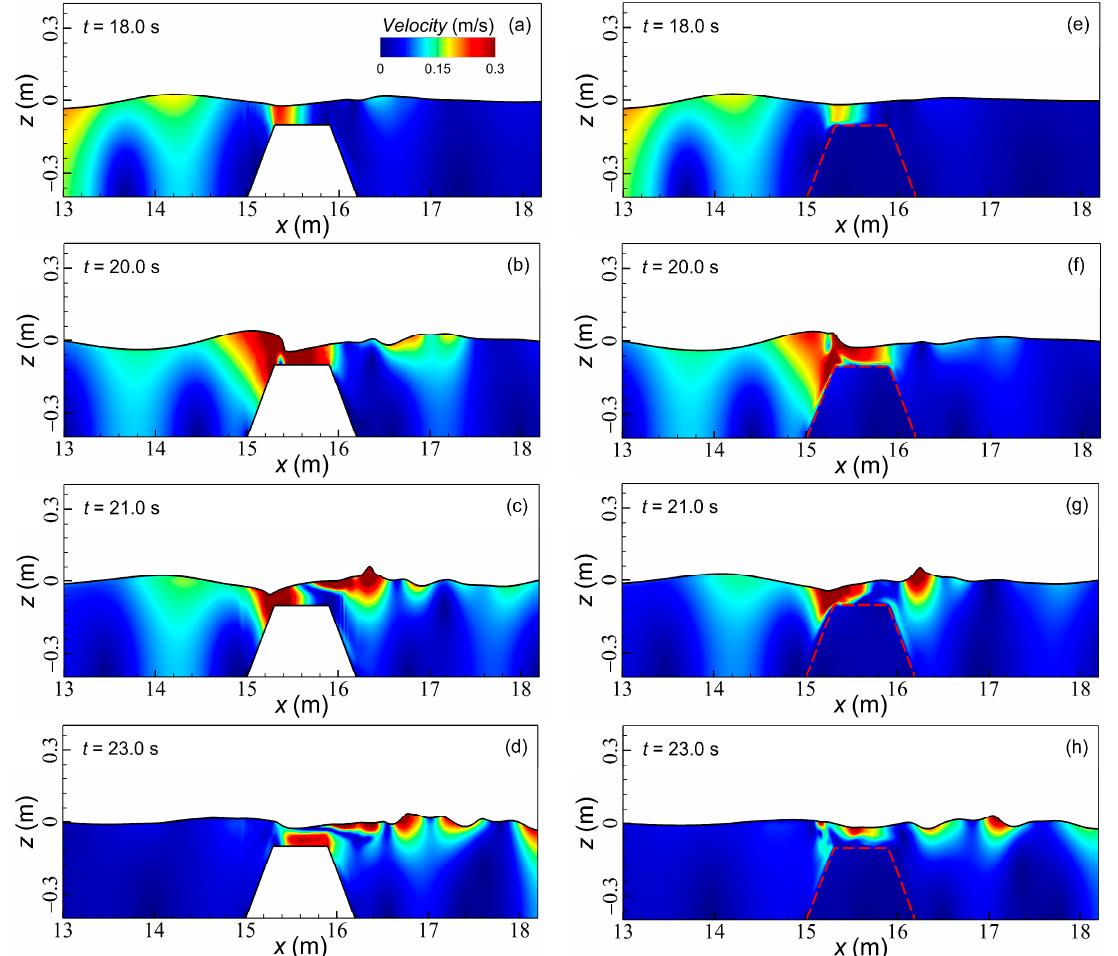
Figure 8. Snapshots of the water velocity contours at different times; left side ( a – d ): submerged impermeable breakwater; right side ( e – h ): submerged permeable breakwater.